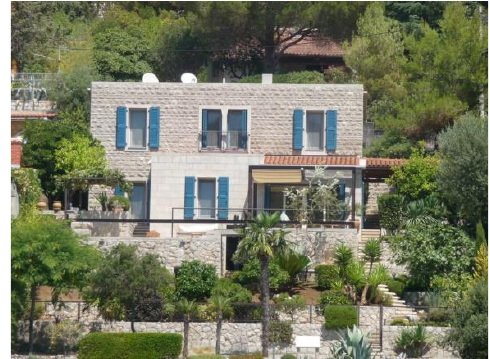
Figure 13. House in Bigova- context-related design (Source: Kosara